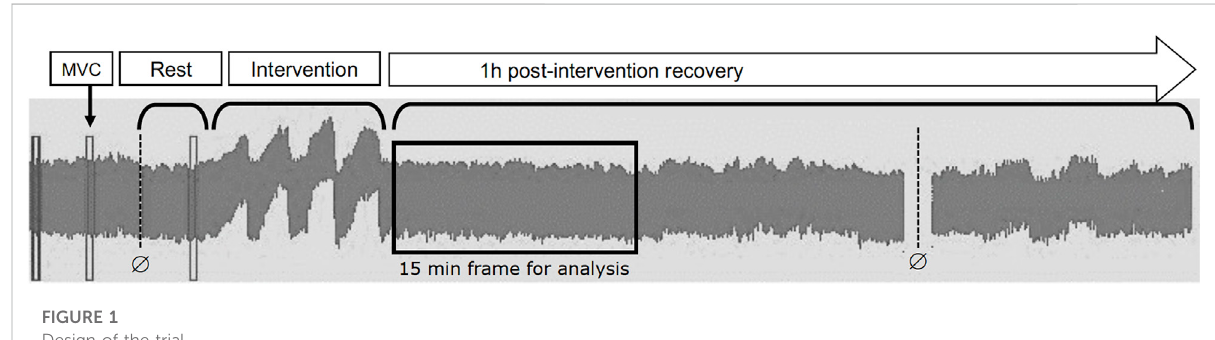
FIGURE 1 Design of the